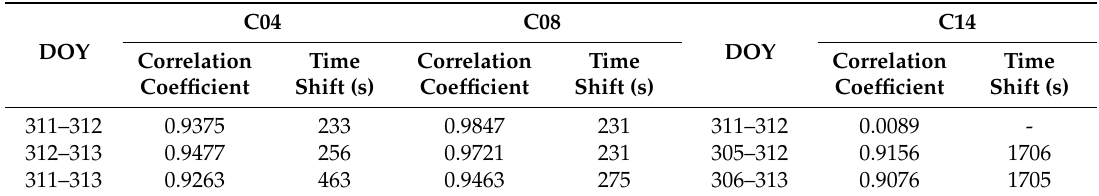
Table 3. Double difference residuals for C04, C08 and C14.